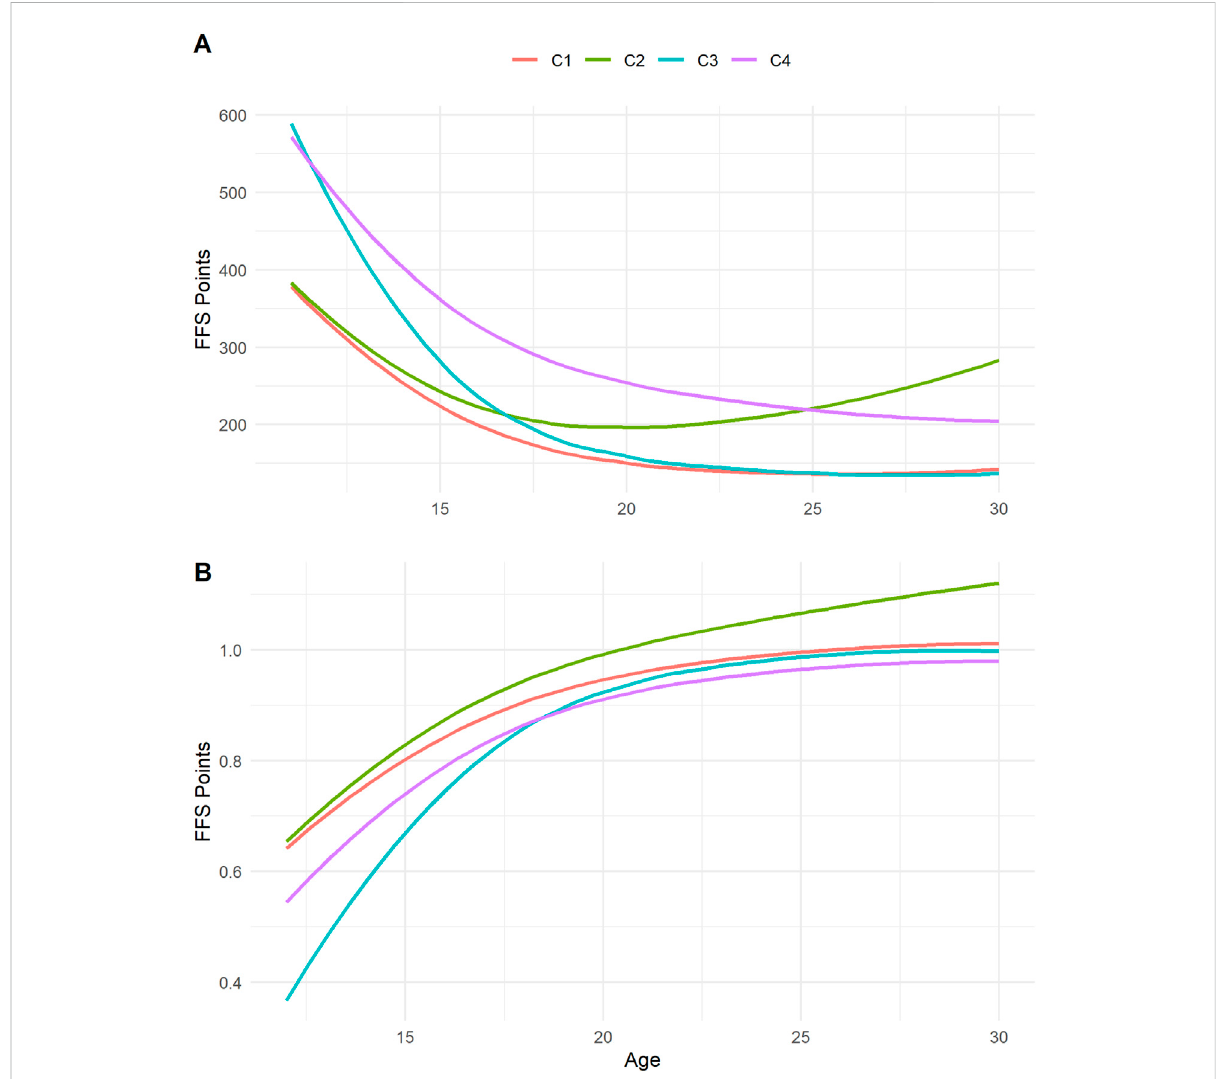
FIGURE 4 Average performance progression curve between the different clusters (A) and the derivatives representing progress (B) . Clusters one and four present different levels of performance but similar levels of progress. Cluster 2 has high young performance but low progression, while cluster 3 has lower young performance but a strong progression